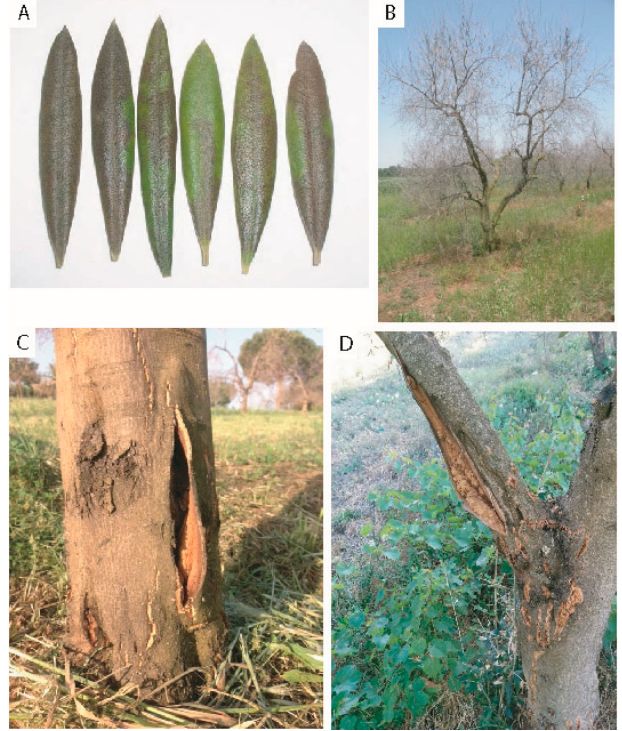
Figure 3. Symptoms of freezing stress: ( A ) leaves chlorotic and brown; ( B ) total defoliation; ( C ) extensive cracks of trunk; ( D ) extensive cracks of branches. The photos were kindly provided by V.Sergeeva and G. Pannelli.